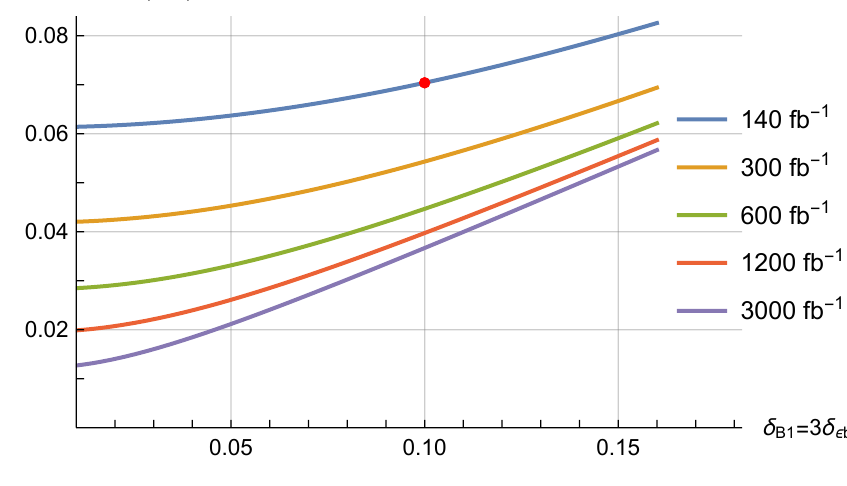
Figure 1 . Estimated fractional error in j V cb j as a function of systematic tagging e(cid:14)ciency uncer- tainties, (cid:14) B = 3 (cid:14) (cid:15) and integrated luminosity. The top curve represents the Run 2 statistics and the 1 b red point on it indicates the illustrative values used in eq. (8.6). The second curve corresponds to luminosity projections for Run 3, while the bottom curve is for the projected integrated luminosity for HL-LHC. We have allowed for a 15% increase in the tt cross-section in the lower three curves, corresponding to an increase in beam collision energy to 14